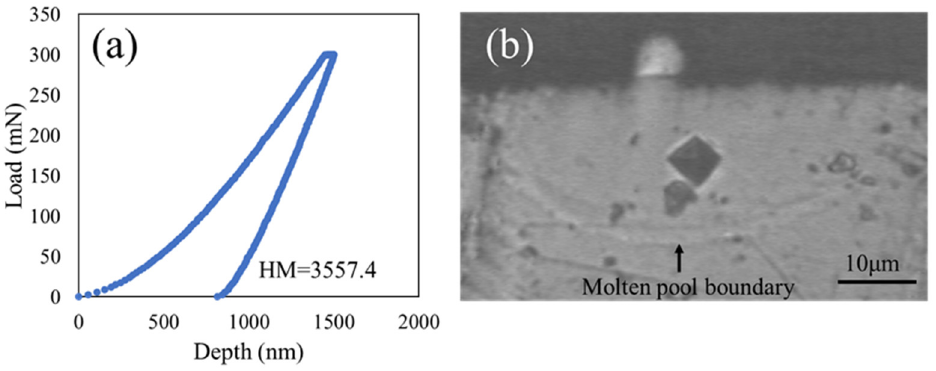
Figure 10. ( a ) Indentation load–penetration depth curve for a MoSiBTiC-La 2 O 3 molten pool; ( b ) OM image of the corresponding indentation print.